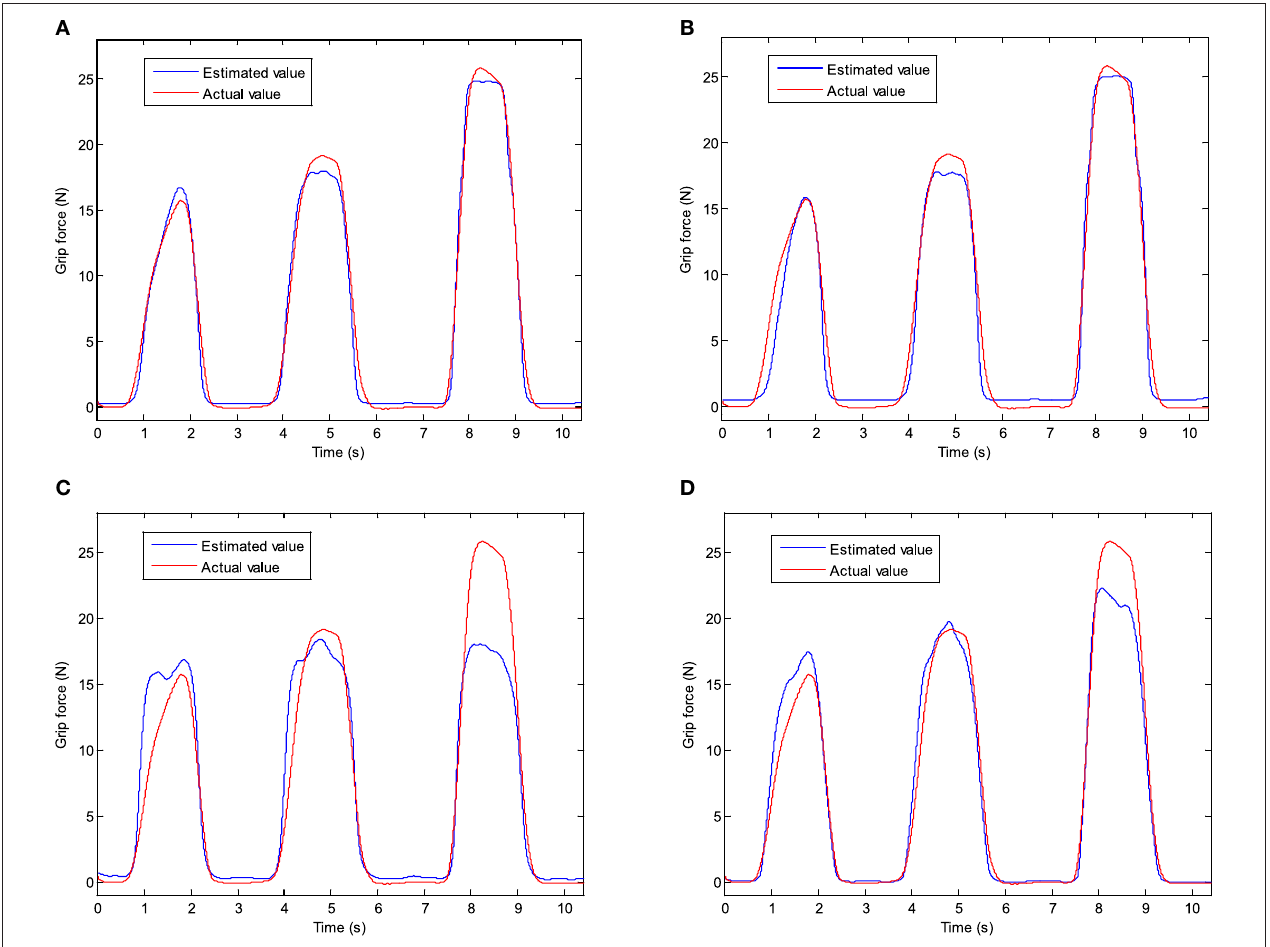
FIGURE 14 | The experiment results of the grip force estimation. (A) Feature = MAV. (B) Feature = VAR. (C) Feature = ZC. (D) Feature = WA.